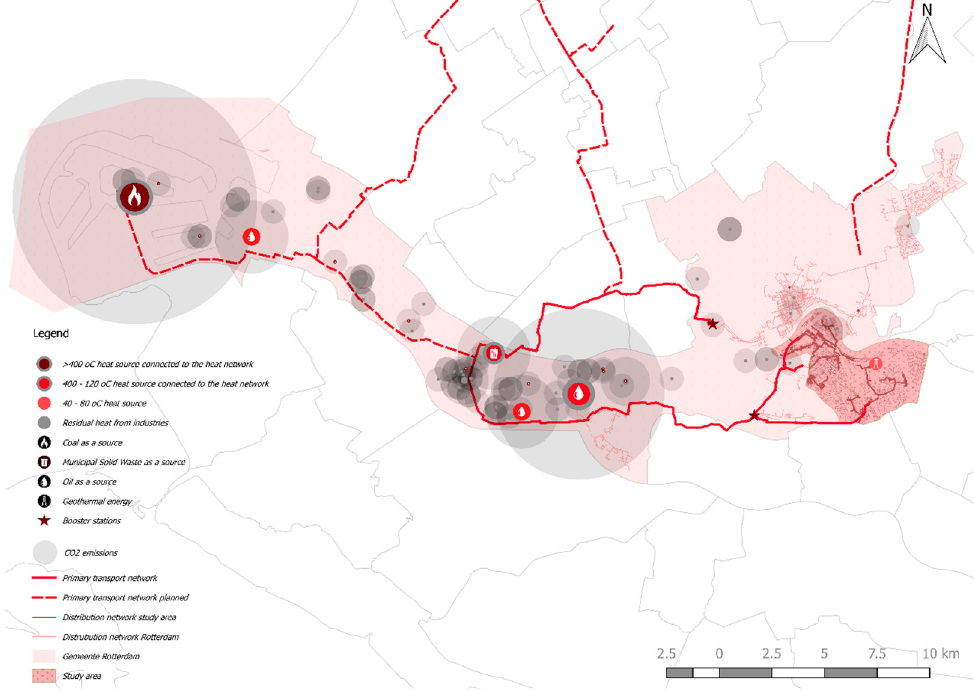
Figure 6. Heat network in Rotterdam and CO 2 emissions from industrial heat sources.